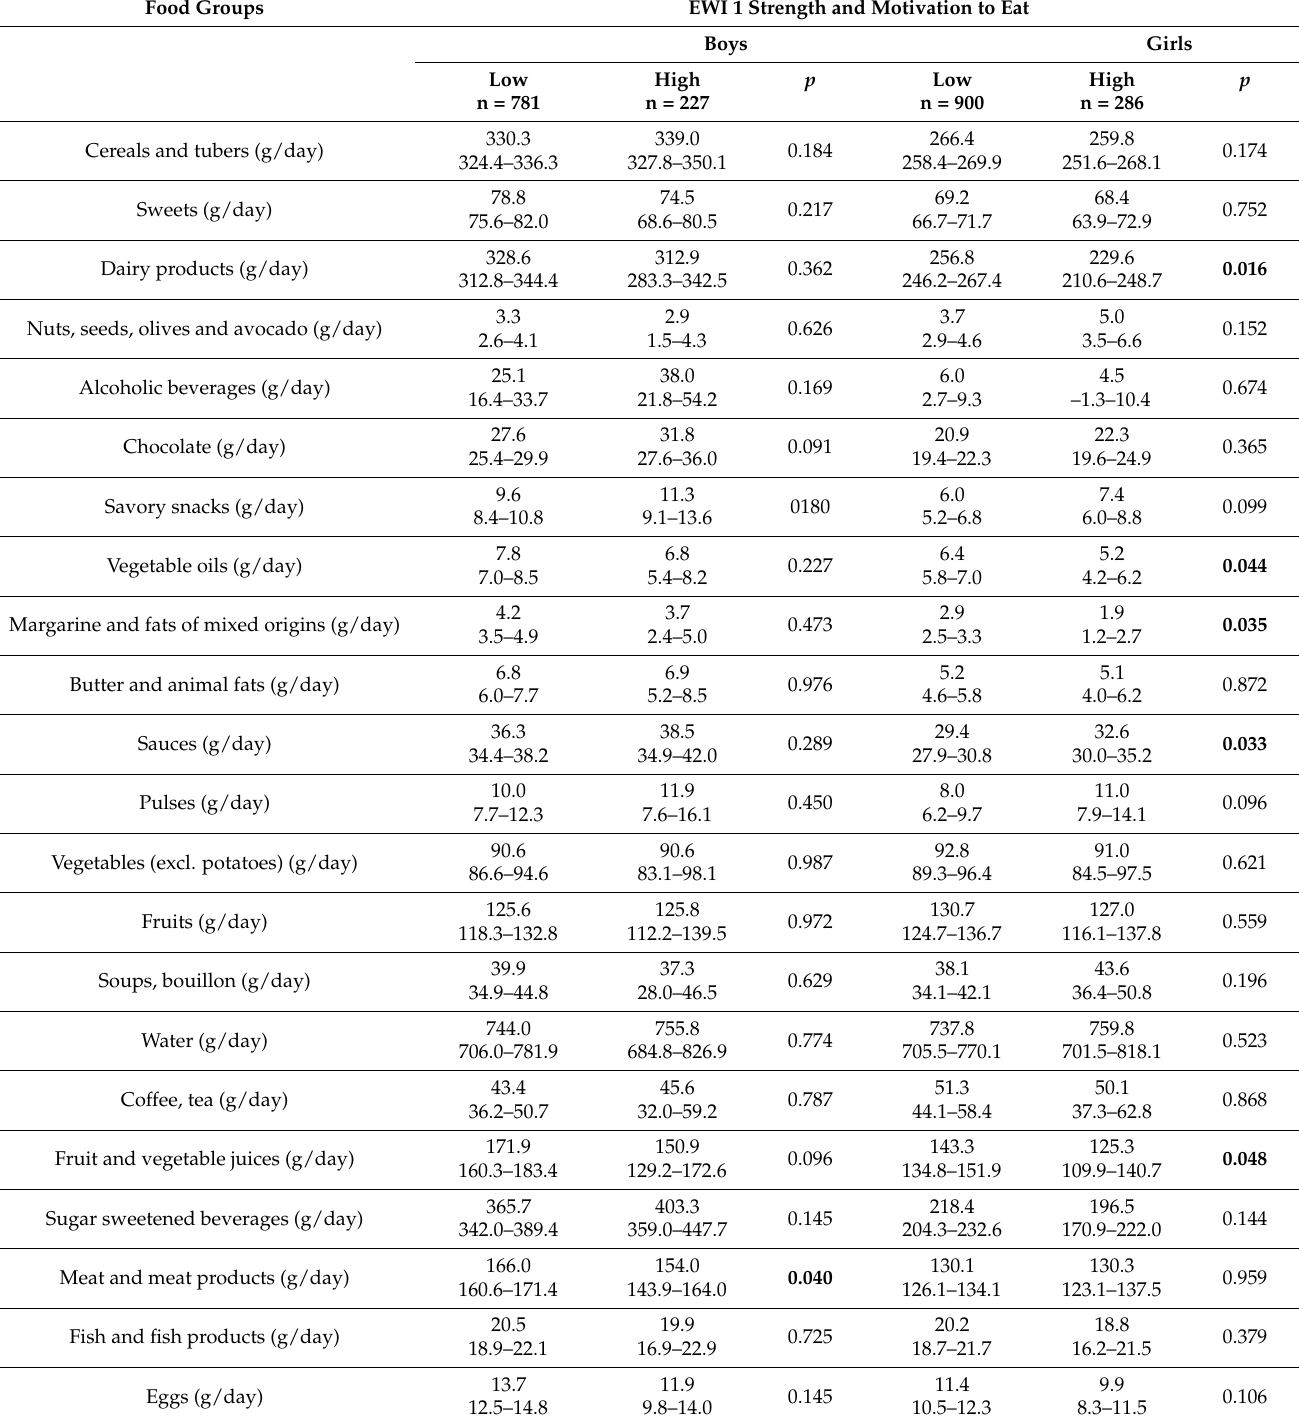
Table 2. Mean (95% CI) intake of food groups by levels of the Strength and motivation to eat component (EWI 1) in adolescents from the HELENA